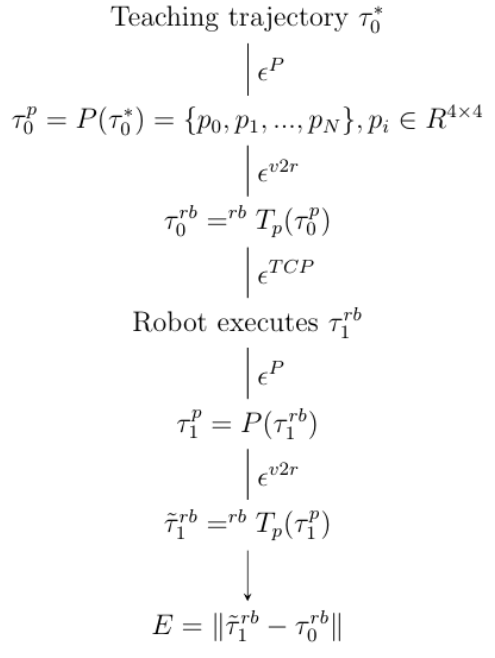
Figure 8. Diagram of the dynamic